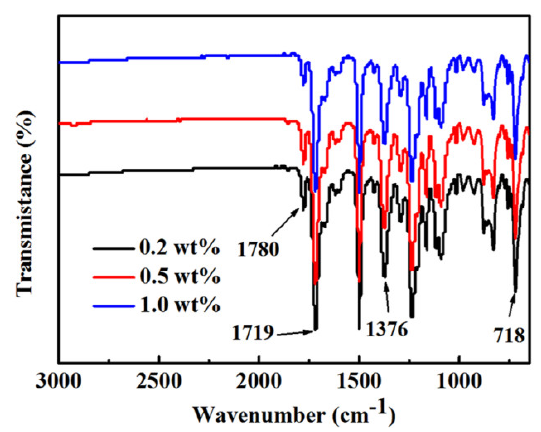
Figure 2. FT － IR spectra of porous PI films. Figure 2. FT-IR spectra of porous PI